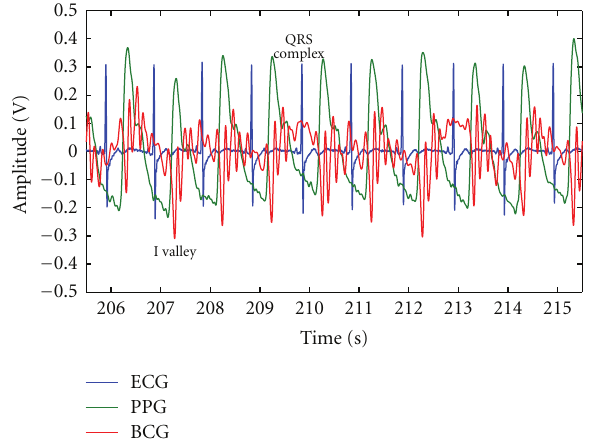
Figure 1: Evolution of the BCG (red), ECG (blue), and PPG (green) signals during 10 seconds, with QRS complex and I valley